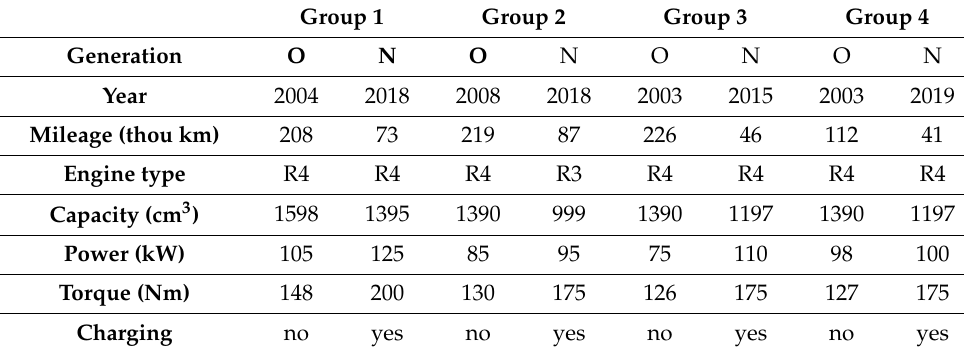
Table 1. Basic parameters of the examined vehicles (Rx—In-line